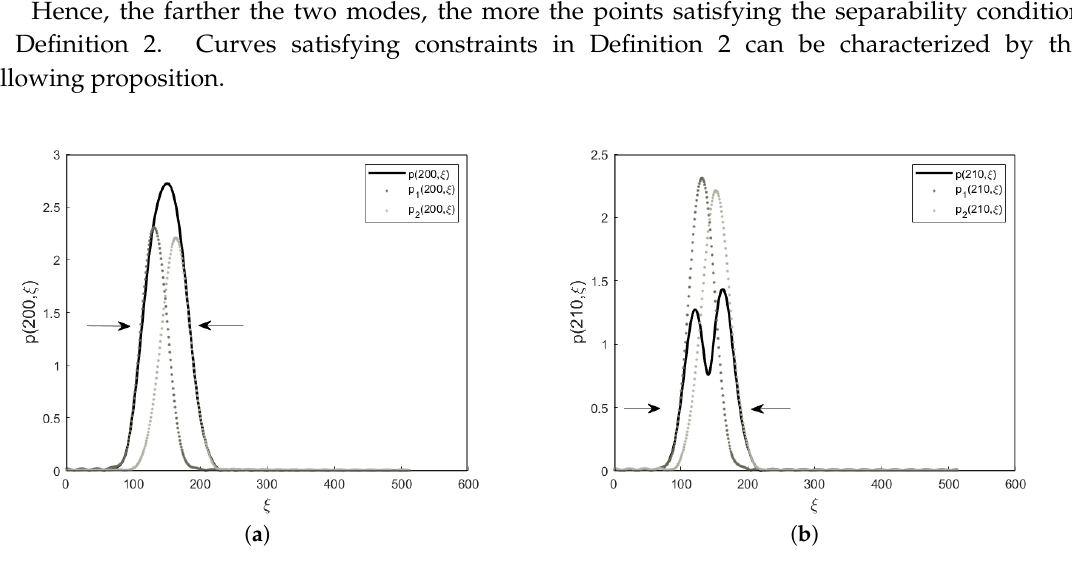
Figure 5. Section at a fixed u in the time-frequency plane of the spectrogram of two different multicomponent signals— u = 200 ( a ), u = 210 ( b ). u belongs to an interference region. As it can be observed, there are several points that satisfy the separability condition even in the interference region—i.e., points where signal spectrogram (solid line) coincides with the spectrogram of one single mode (dotted